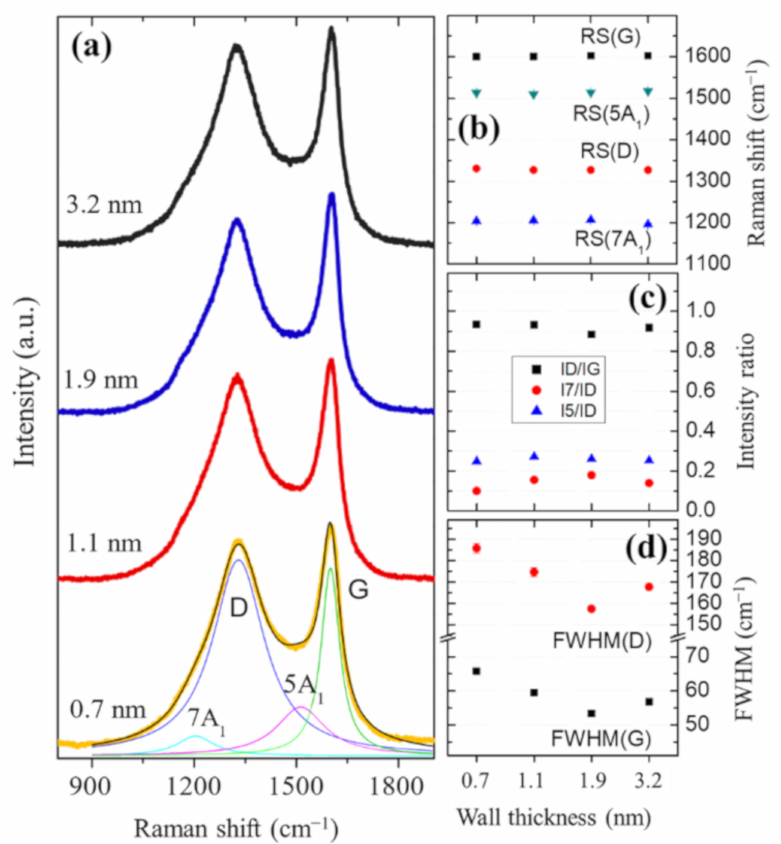
Figure 3. ( a ) Raman spectra of LC-CNTs as a function of wall thickness. ( b ) Peak position of reso- nances 7A 1 , D, 5A 1 , G. ( c ) Representative ratio of I(D)/I(G), I(7A 1 )/I(D), and I(5A 1 )/I(D). ( d ) FWHM of G and D